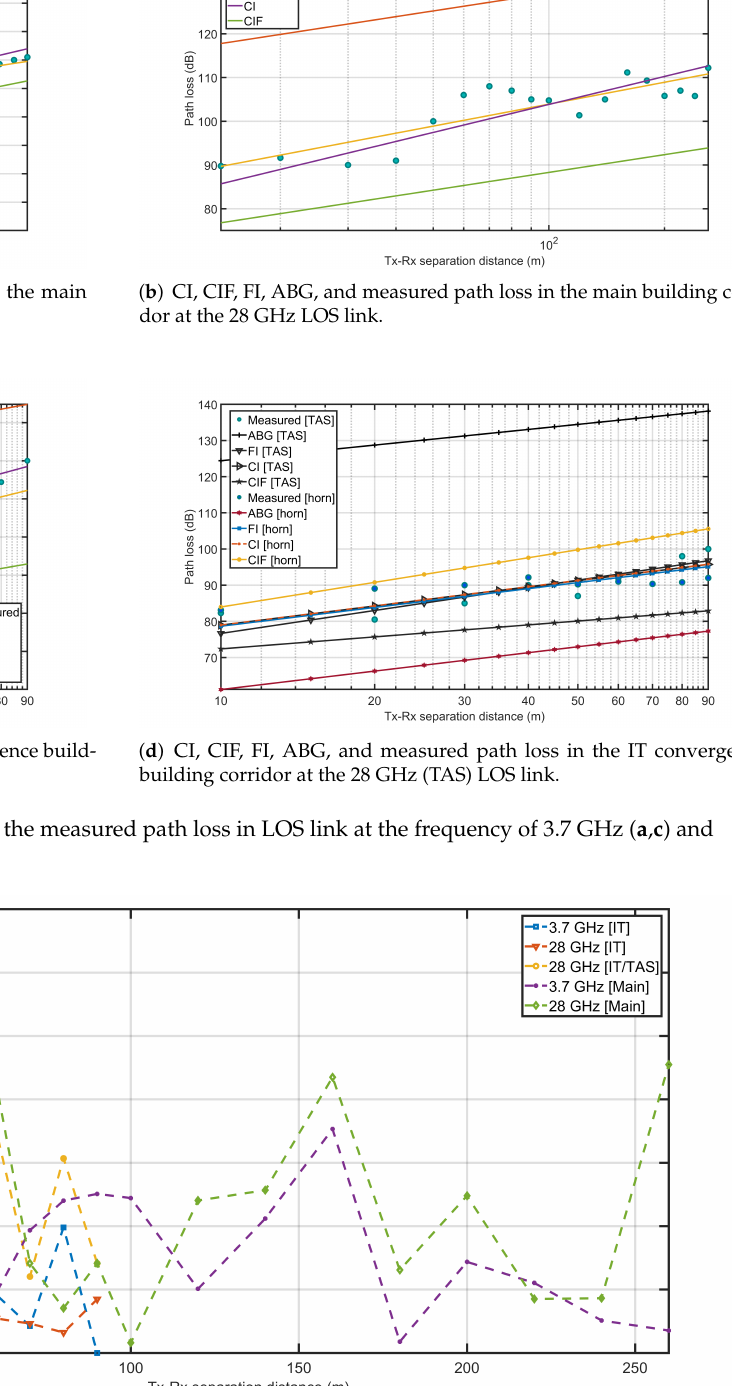
Figure 7. The figure depicts the point-to-point standard deviation of recorded data at 3.7 and 28 GHz under various antenna